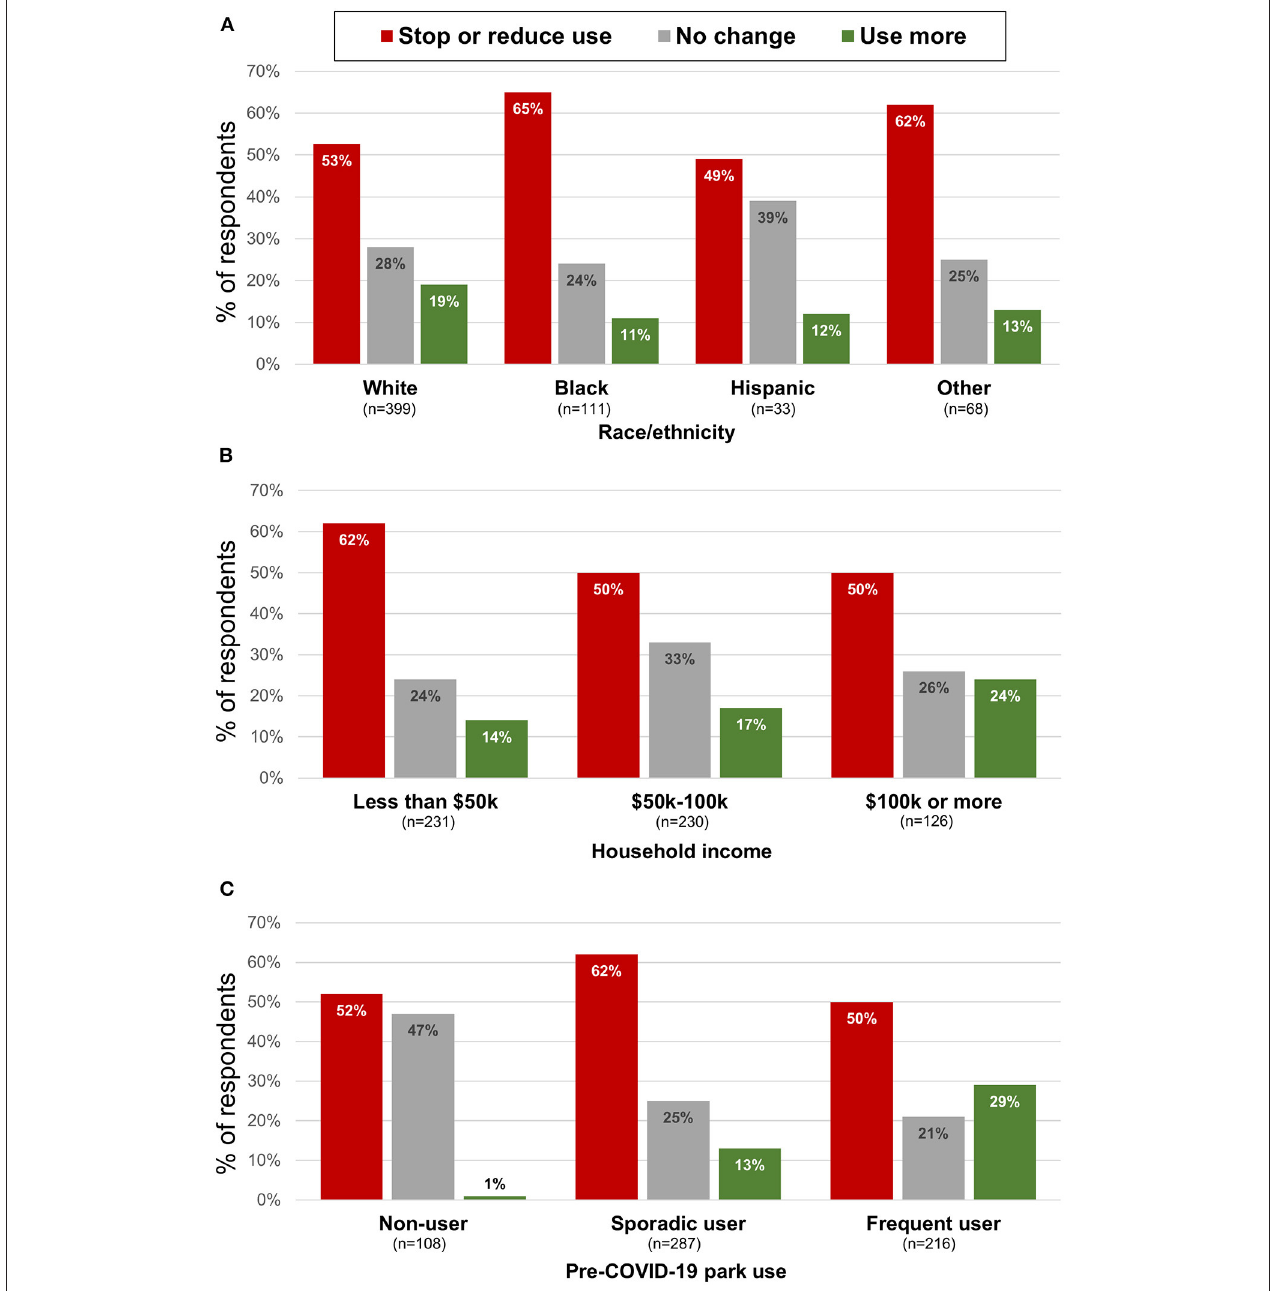
FIGURE 2 | Differences in outdoor park use changes during COVID-19 by (A) race/ethnicity ( X 2 (6) = 10.2, p = 0.116, Cramer’s V = 0.091), (B) household income ( X 2 (4) = 11.1, p = 0.025, Cramer’s V = 0.097), and (C) pre-COVID-19 park use levels ( X 2 (4) = 60.7, p < 0.001, Cramer’s V = 0.223). Data are based on an August 2020 survey of urban residents in NC ( n =